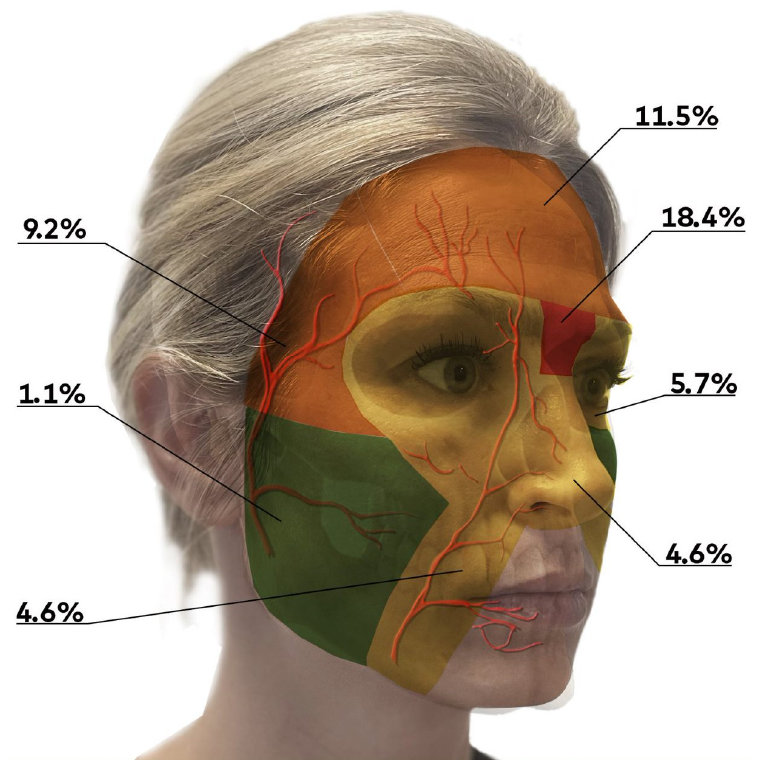
Figure 2. a Risk-based facial